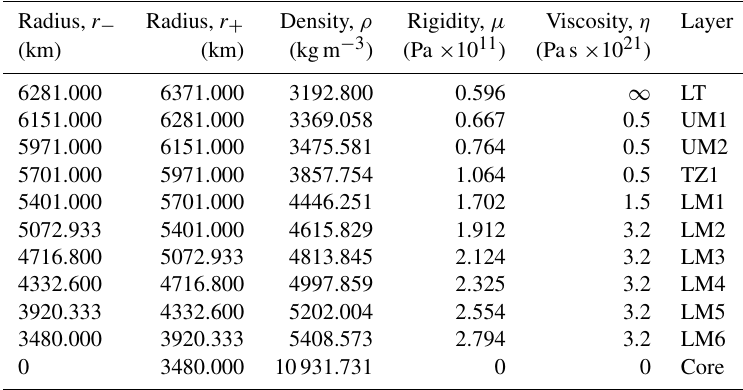
Figure 3. Elastic (a) and fluid (b) LLNs as a function of harmonic degree l for the 11-layer rheological VM5i model employed in the test run (see Table 2). It is apparent that for this model asymptotic values are reached, in both cases, for l exceeding values of several hundred. Note that in panel (b) , where the fluid LLN for vertical displacement is normalized by ( 2 l + 1 ) , the relationship h Lf Table 2. Density, rigidity, and viscosity profiles adopted in the rheological VM5i model, where abbreviations LT, UM, TZ, and LM stand for lithosphere, upper mantle, transition zone, and lower mantle, respectively. The radii r − and r + indicate the lower and upper radii of each layer. Some spectral properties of the VM5i model are given in Fig. 3 and Table 3. Radius, r − Radius, r + Density, ρ Rigidity, µ Viscosity, η Layer (km) (km) (kgm − 3